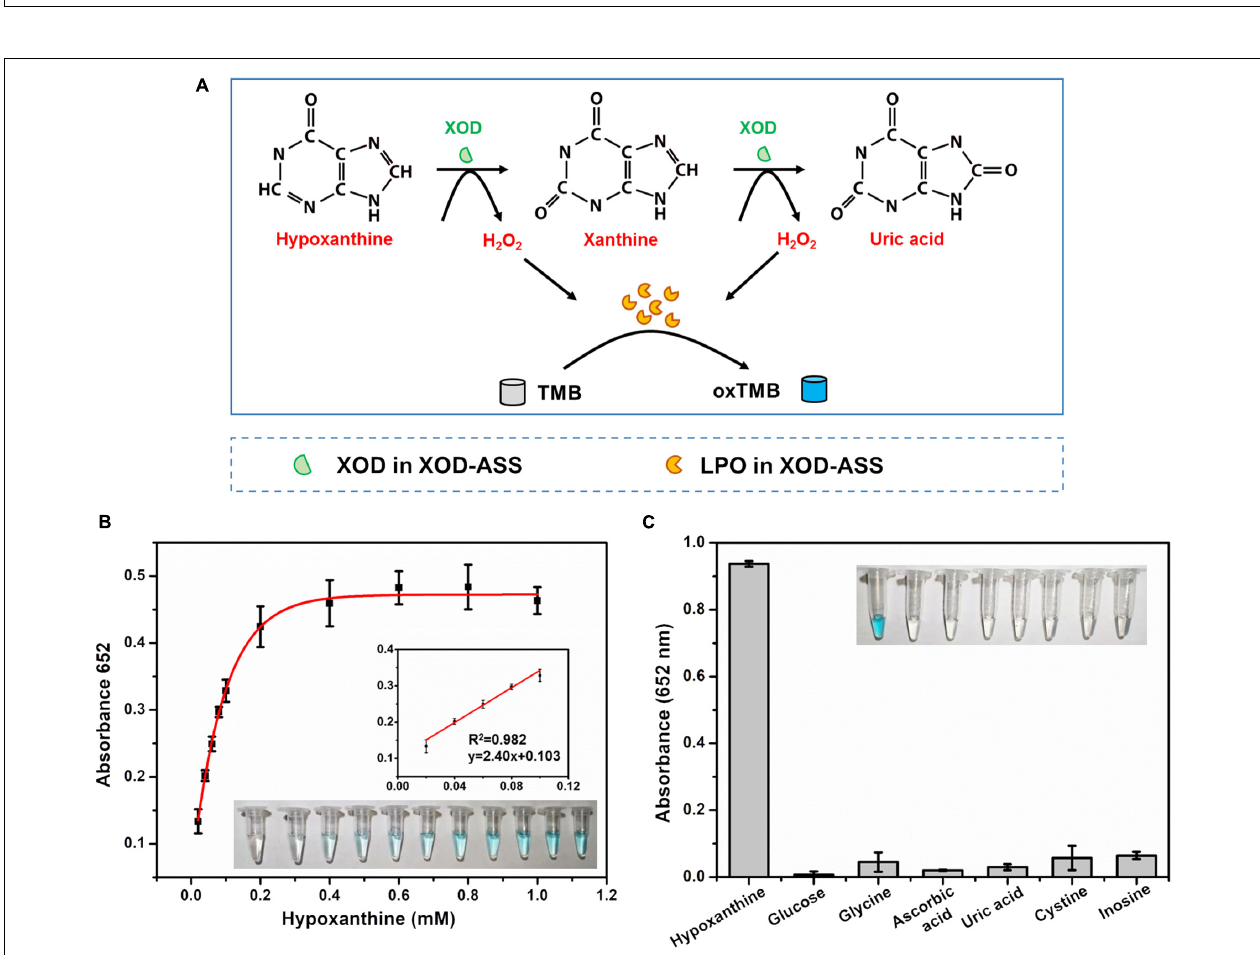
FIGURE 3 | (A) Schematic illustration of one-step and colorimetric detection of Hx catalyzed by XOD-ASS. (B) The absorbance at 652 nm in different concentrations of Hx. Inset represents the corresponding colorimetric result of the reactions and the linear calibration plot for Hx. (C) Selectivity of the established one-step Hx detection